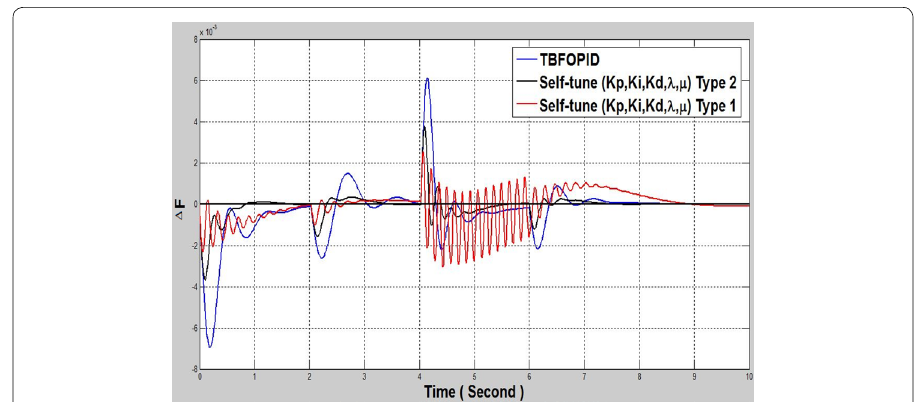
Fig. 30 Response of Δ F via IT2FST and T1FST for TSMFOPID ( k p , k i , k d , λ and μ ) with parameter uncertainties